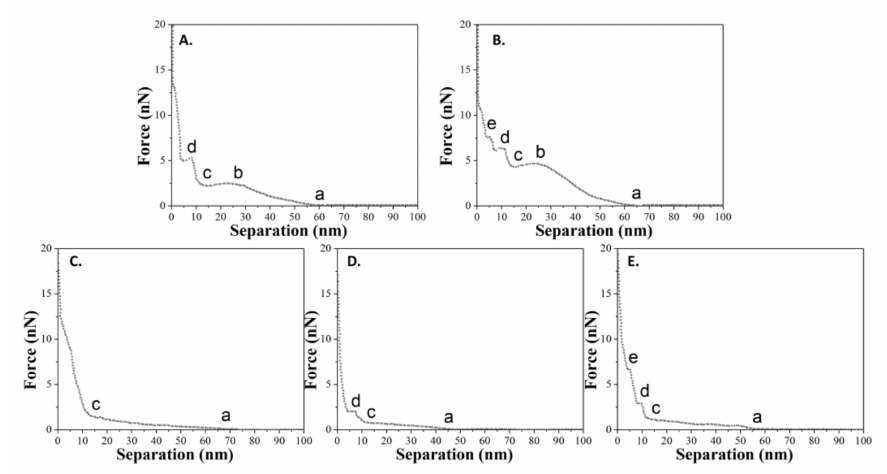
Figure 8. A summary of all types of force-distance curves (approach) for spherical vesicles adsorbed onto titanium alloy. ( A , B ) belong to the case where T 1 = 60 ◦ C; ( C – E ) belong to the case where T 2 = 25 ◦